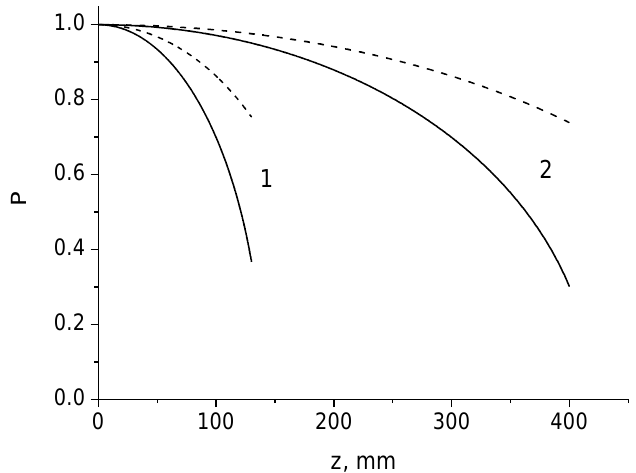
Figure 2. The degree of linear polarization as a function of distance for both meridional and sagittal rays (solid curves) and only for meridional rays (dashed curves). (1) x 0 = 15 µ m; (2) x 0 = 5 µ m. In Figure 3 the values